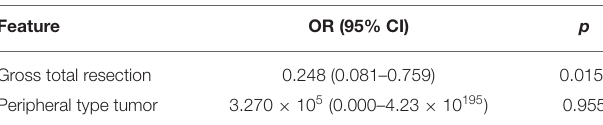
TABLE 3 | Cox regression analysis for predictors of recurrence/progression after